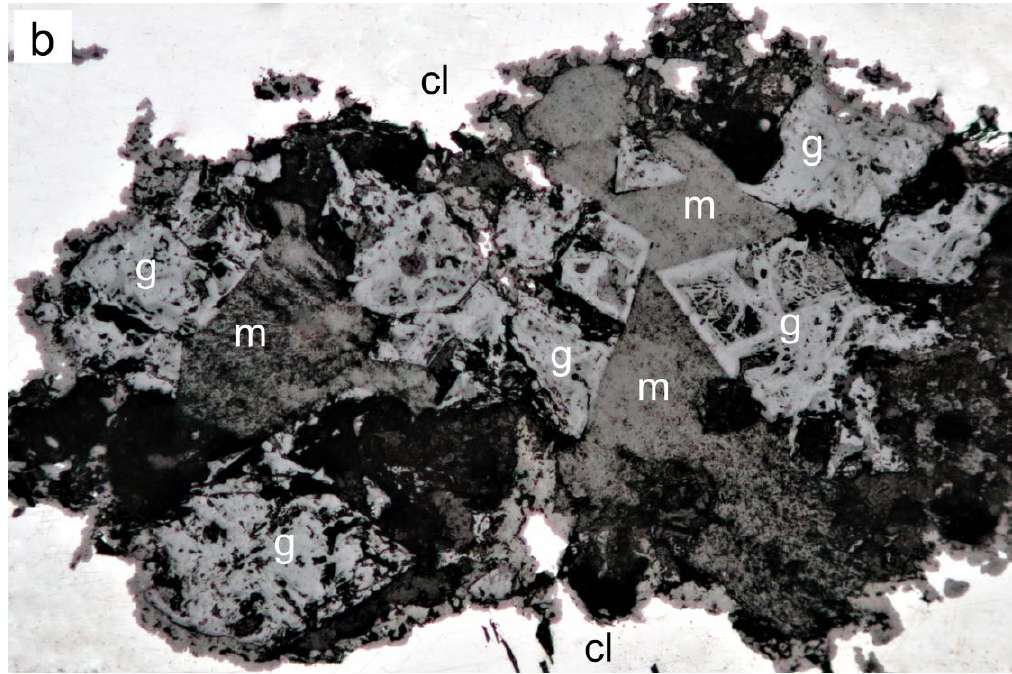
Figure 4. ( a ) Irregular dark-brown patches of bitumen (see white arrows) as fracture fillings cementing the host-rock fragments from the vein wall inwards (cf. Figure 5d). The bright grains are pseudomorphs of TiO 2 after titanomagnetite. Polished section, plane polarized reflected light digital image, width 200 μm; ( b ) Goethite (g) pseudomorph after ankerite (?) cemented by acicular malachite (m) embedded in clausthalite (cl, white). Polished section, reflected light image, width 1 mm, plane polarized light.